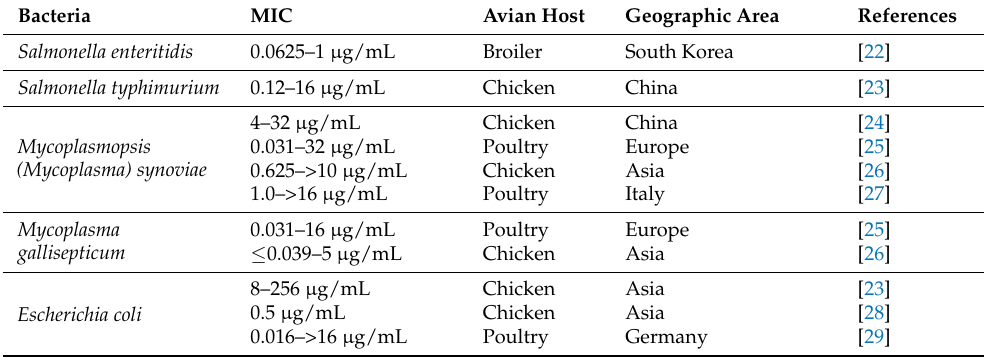
Table 3. Minimal inhibitory concentrations (MICs) of enrofloxacin-sensitive bacteria in birds. Data are based on papers found in PubMed using the keywords birds, enrofloxacin, MIC, eye, ophthalmology, and ophthalmological, and the name of the respective pathogen published between January 2015 and September